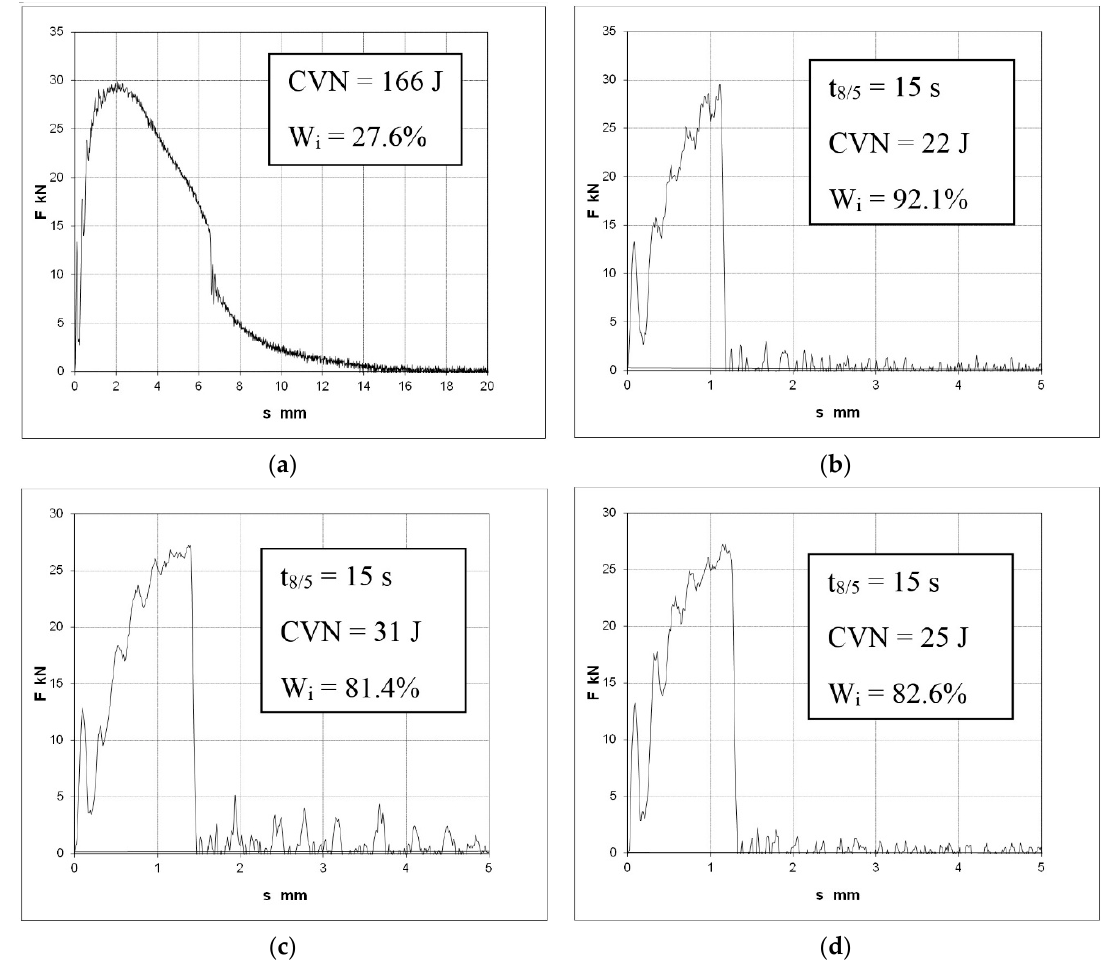
Figure 10. Registered force-displacement diagrams: ( a ) base material, ( b) CGHAZ, ( c ) ICHAZ, ( d ) ICCGHAZ Table 5. Percentage of the absorbed energy for crack initiation compared to CVN.